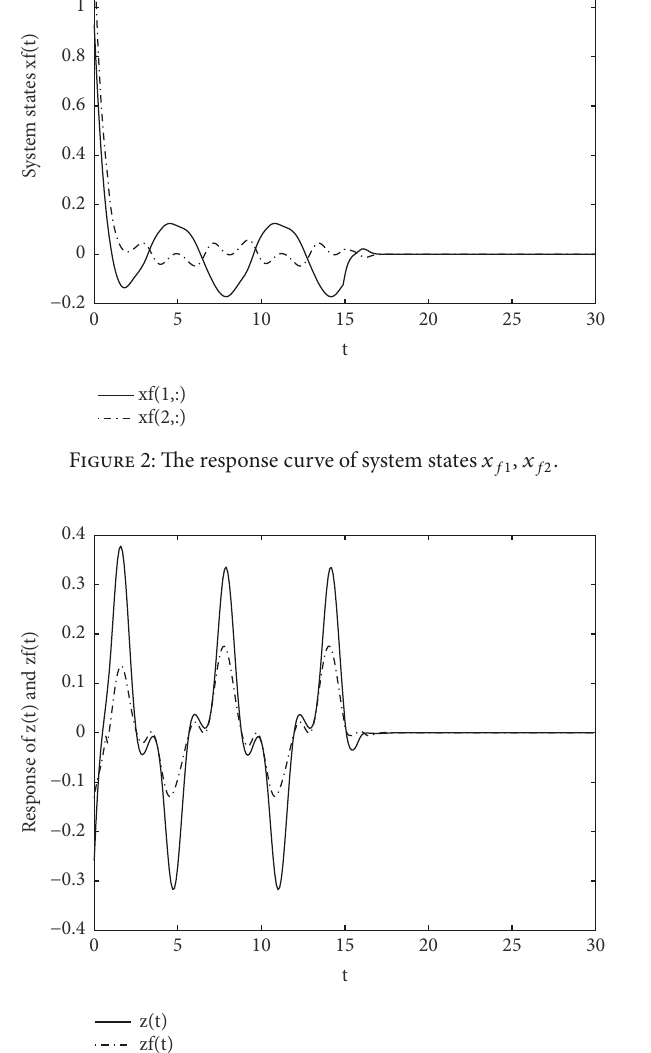
Figure 3: The response curve of vector 𝑧( t ) , 𝑧 𝑓 ( t ) .